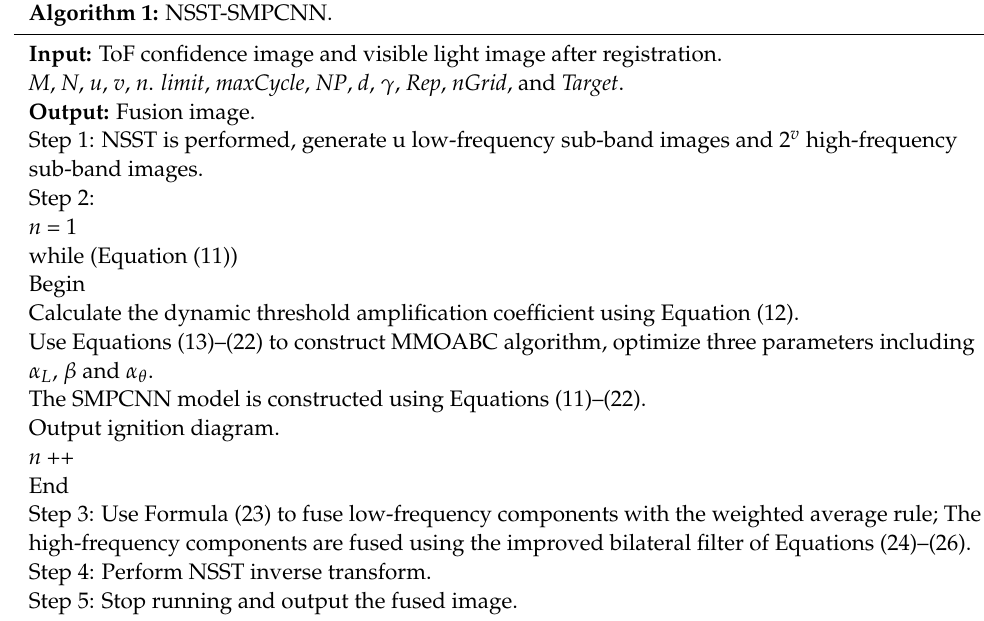
Algorithm 1: Algorithm 1: NSST ‐ SMPCNN.